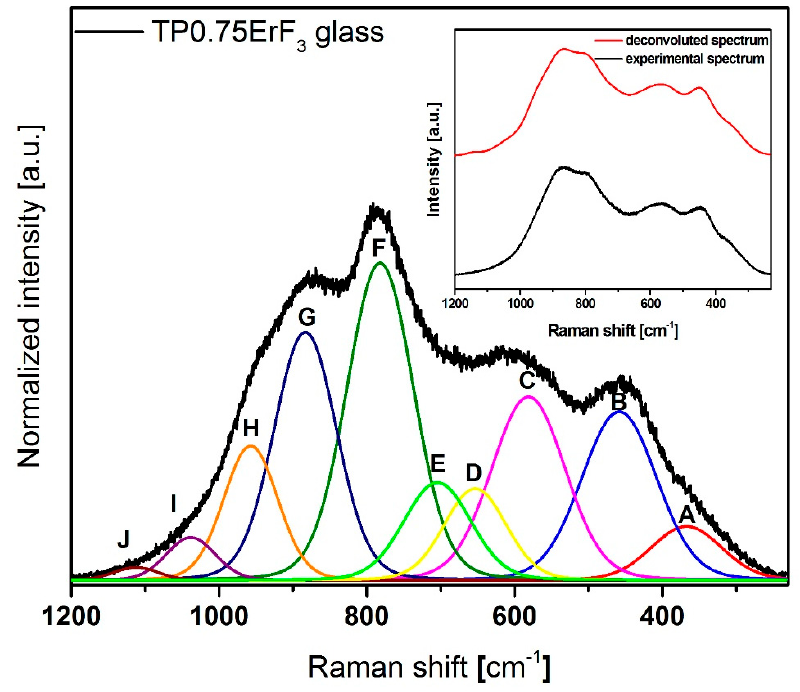
Figure 10. Deconvoluted Raman spectra of TP0.75ErF 3 glass. (inset) Deconvoluted and experimental spectra.